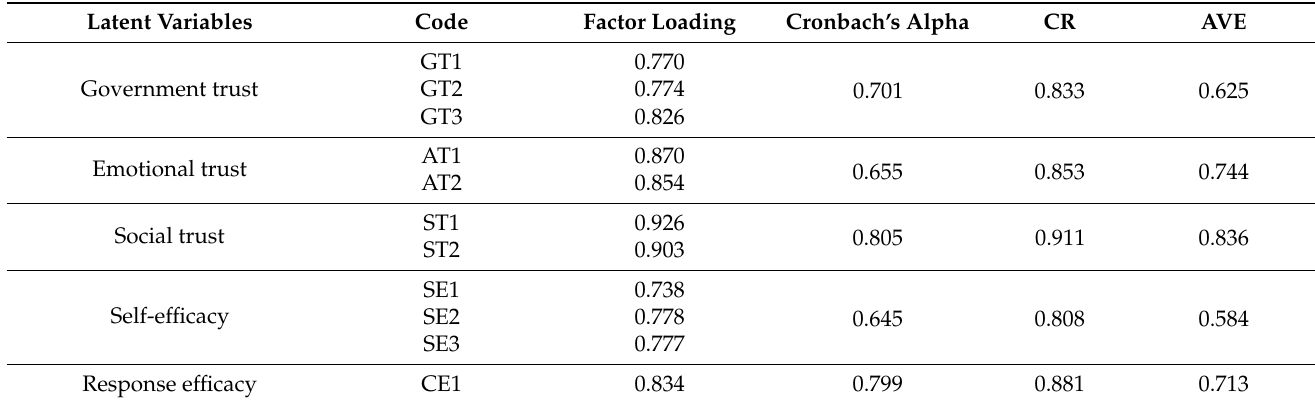
Table 4. Validity and reliability analysis of the measurement